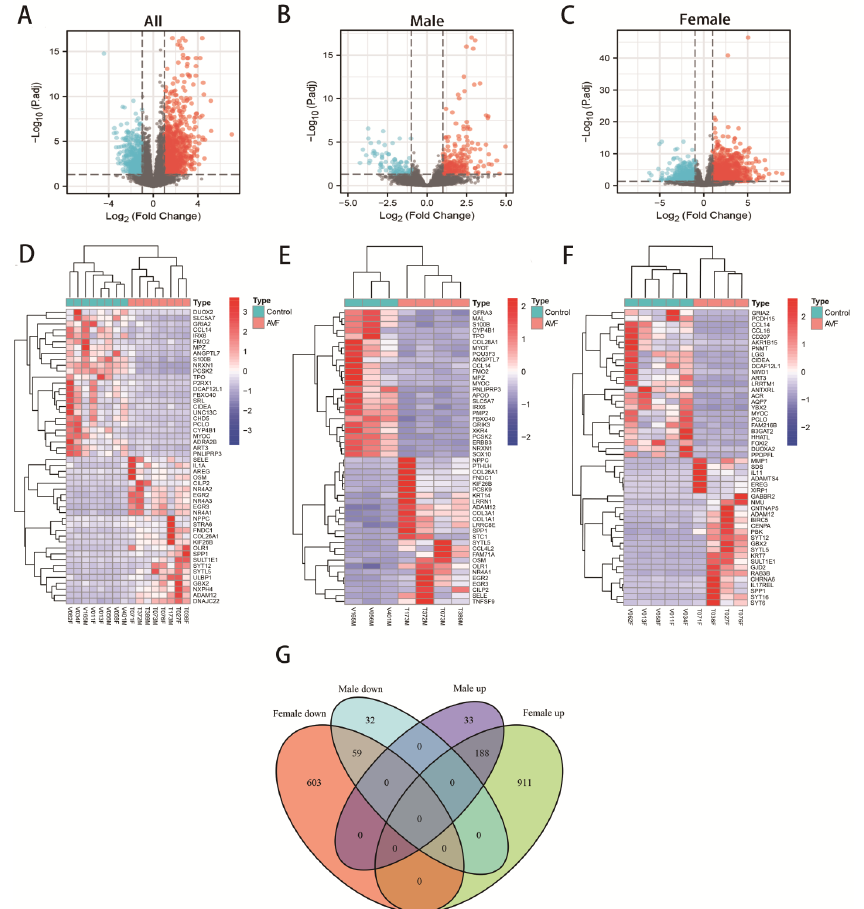
Figure 3. Identification of non-specific, male-specific and female-specific DEGs and Venn plots. ( A ) Volcano plot showing the non-specific DEGs. ( B ) Volcano plot showing the male-specific DEGs. ( C ) Volcano plot showing the female-specific DEGs. ( D ) Cluster heatmap of the non-specific DEGs. ( E ) Cluster heatmap of the male-specific DEGs. ( F ) Cluster heatmap of the female-specific DEGs. ( G ) Venn plots drawn for the upregulated and downregulated DEGs with male and female specificity. GO and KEGG enrichment analyses were performed based on DEGs between the native veins and the AVF group. To discover whether there were differences in sex,